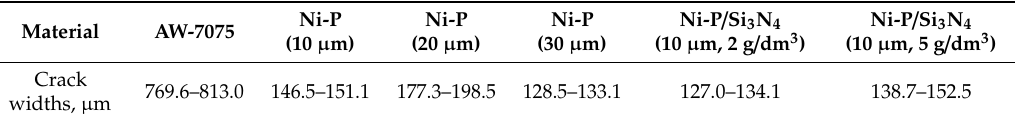
Table 8. Lists the crack widths for individual samples (the first